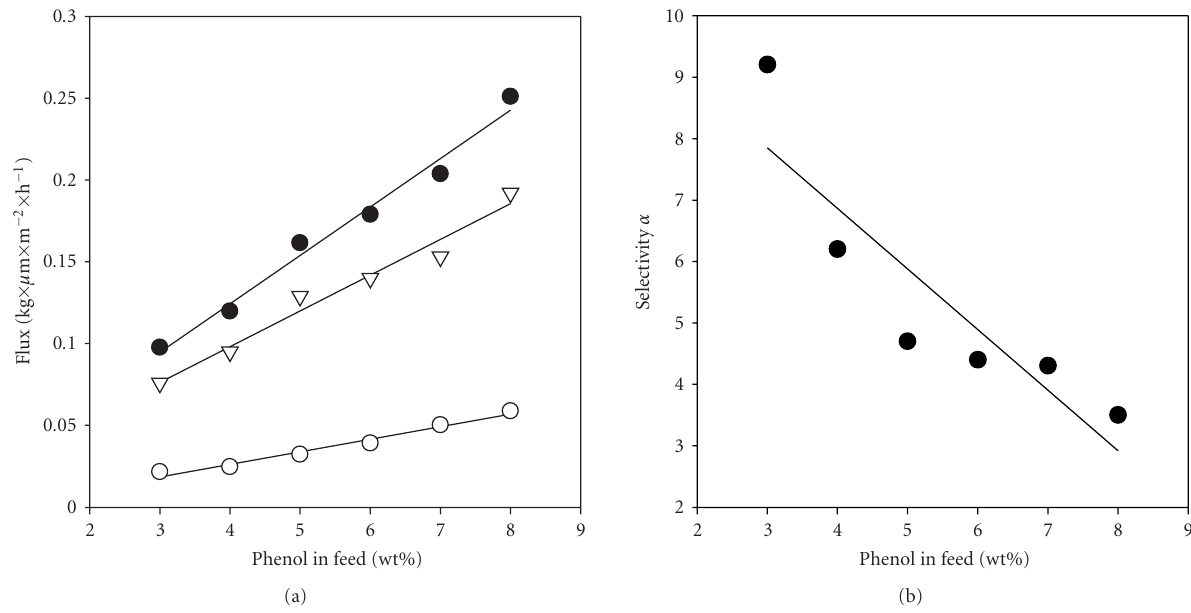
Figure 7: (a) Total flux ( • ), partial water flux ( (cid:2) ), and partial phenol flux ( (cid:4) ) and (b) separation factor with increasing phenol concentration in the feed mixture for the E-MAA 27 at 313 K and a permeate pressure of 15–30 mbar. Table 3: Mass uptake of E-MAA 27 in di ff erent composed phenol/water mixtures.